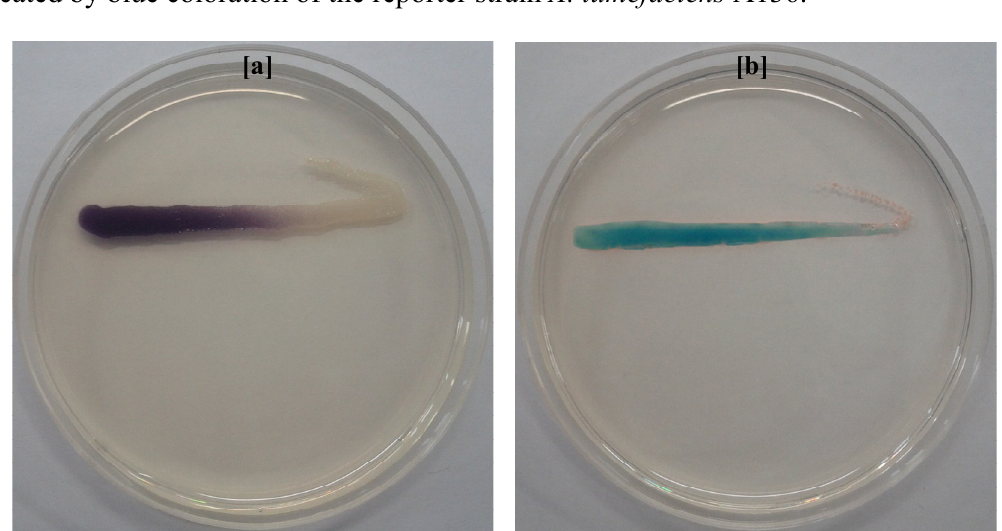
Figure 5. Detection of AHLs extracted from activated sludge by agar-plate cross feeding violacein and β -galactosidase assay with C. violaceum CV026 and A. tumefaciens A136 respectively. ( a ) Evidence for the presence of short and medium-chain AHLs in activated sludge extract is indicated by purple coloration of the reporter strain C. violaceum CV026; ( b ) Evidence for the presence of medium and long-chain AHLs activated sludge extract is indicated by blue coloration of the reporter strain A. tumefaciens